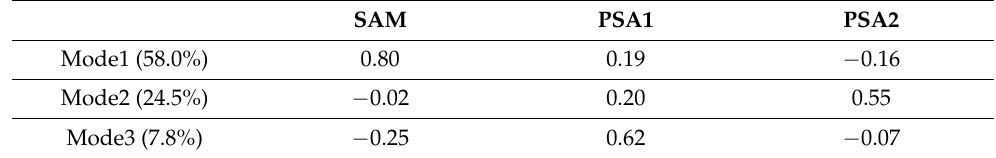
Table 2. The correlation coefficients between the time series of the first three modes of the combined maximum covariance analysis (CMCA) for annual surface air temperature (SAT) anomalies, and of the three principal components of the circulation over the Antarctic: the southern annular mode, and the first and second Pacific South American modes. SAM PSA1 PSA2 Mode1 (58.0%) 0.80 0.19 − 0.16 Mode2 (24.5%) − 0.02 0.20 0.55 Mode3 (7.8%) − 0.25 0.62 −